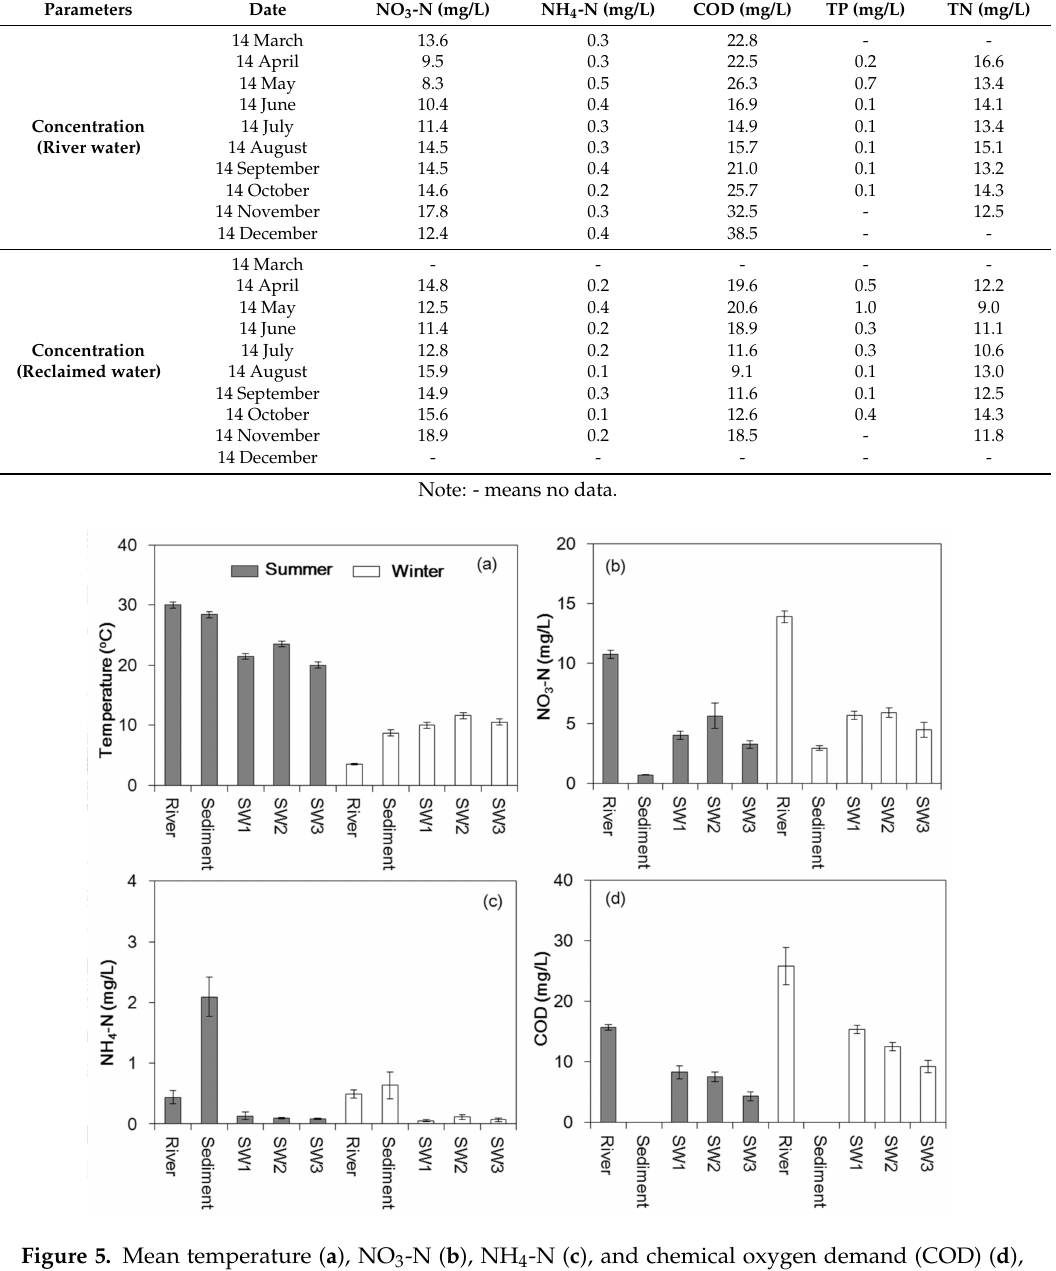
Figure 5. Mean temperature ( a ), NO 3 -N ( b ), NH 4 -N ( c ), and chemical oxygen demand (COD) ( d ), in river water, interstitial water and shallow groundwater in the three sampling wells (SW1, SW2, SW3) for the summer (n = 15) and winter months (n = 15) of